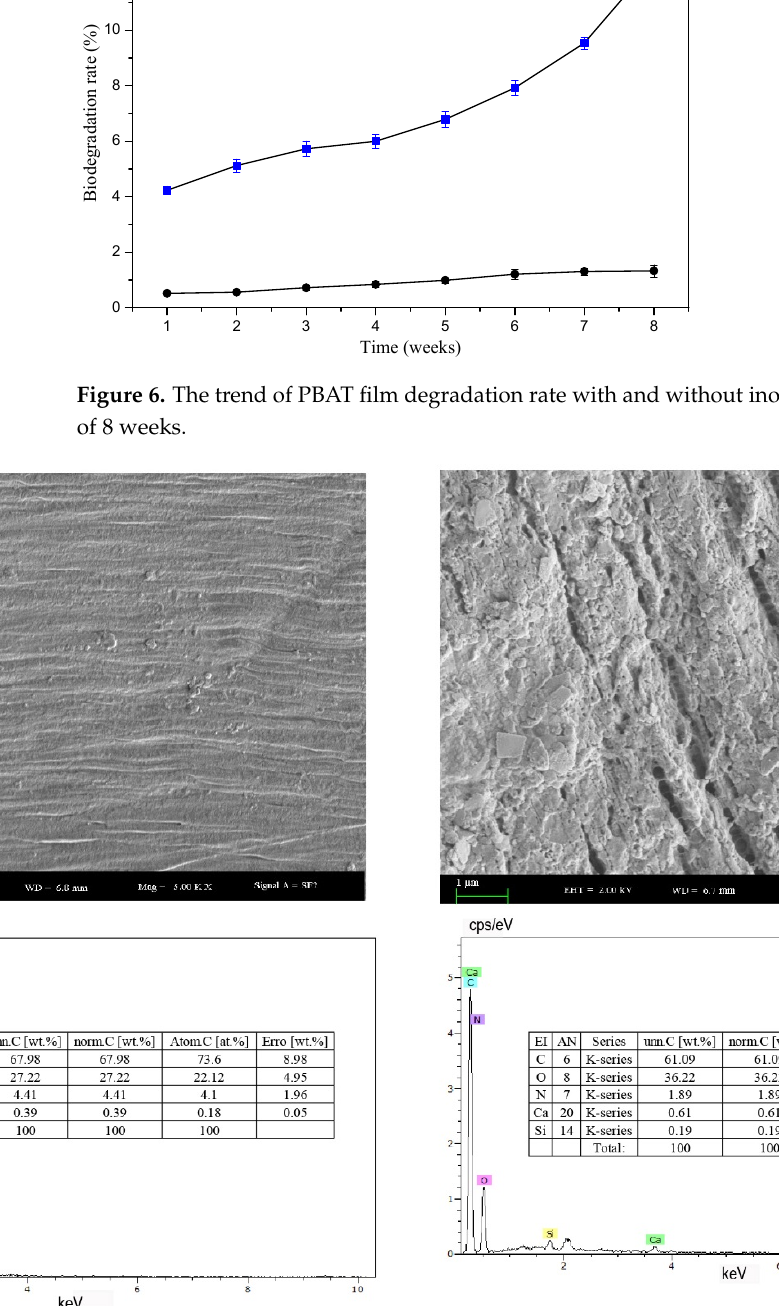
Figure 7. SEM images and EDX spectra of the PBAT film before and after the 8 weeks degradation by strain Peribacillus frigoritolerans S2313; ( a ) SEM image before the degradation; ( b) SEM image after the 8 weeks degradation; ( c ) EDX spectra before the degradation; ( d ) EDX spectra after the degradation. Typical images and spectra are shown from one of the triplicate examinations.